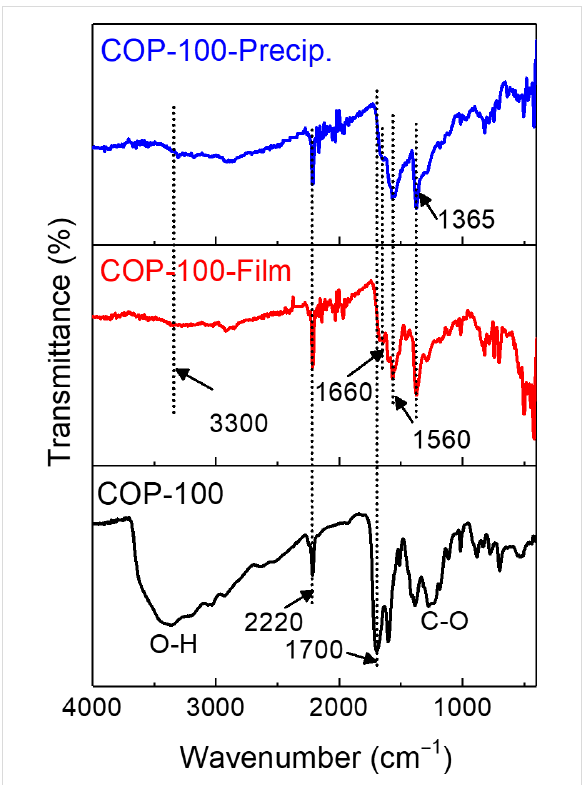
Figure 4: FTIR spectra of COP-100, COP-100-Film, and COP-100- Precip. COP-100 exhibited two peaks at 3400 cm − 1 and 1375 cm − 1